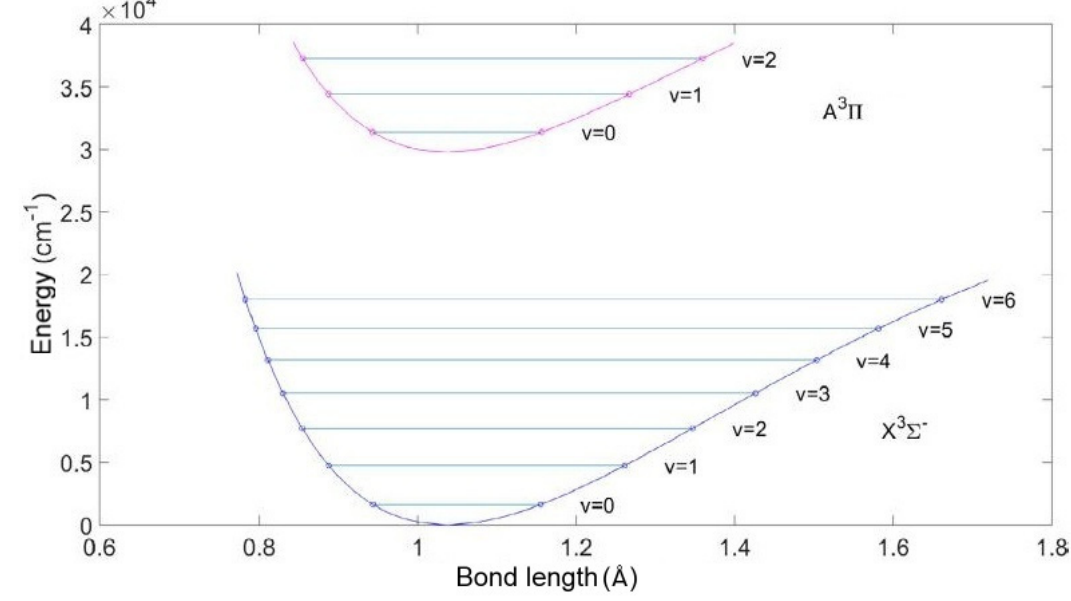
Figure 13. Potential curves for low-lying energy levels of NH [125]. The fi rst spectral detection of the NH radical is dated to 1893 by J. M. Eder [126]